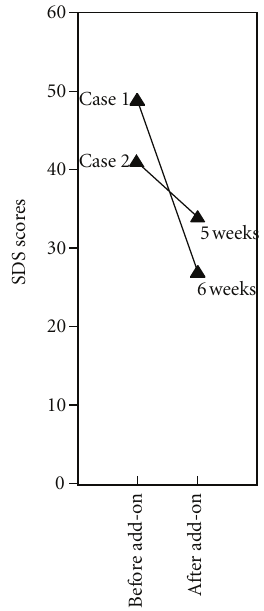
Figure 1: SDS scores before and after the add-on treatment with lamotrigine. SDS evaluations were performed before, and at 5 and 6 weeks after beginning